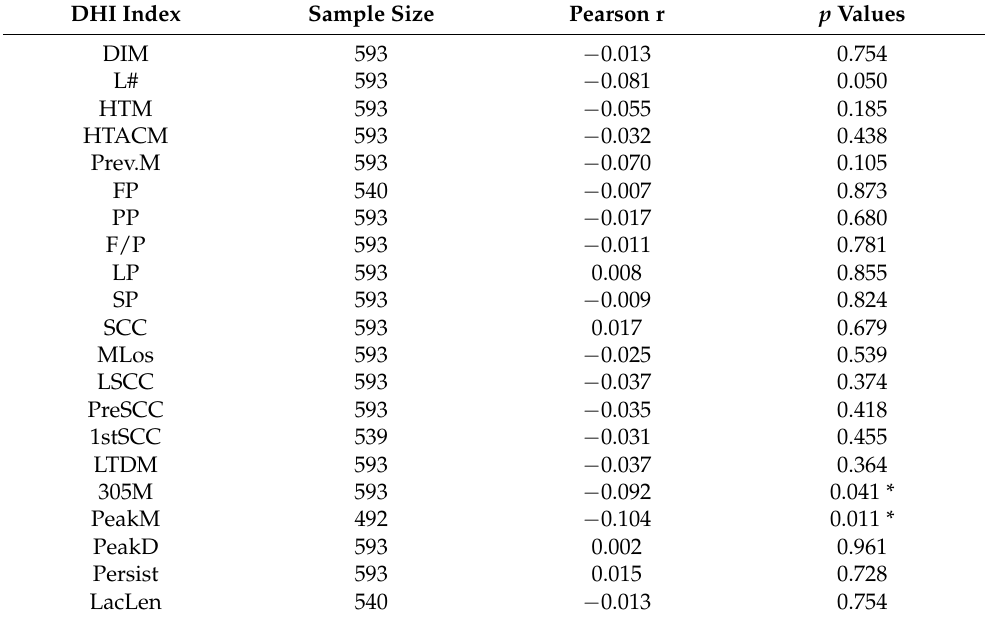
Table 1. Pearson correlation analysis between MT in milk and DHI index.